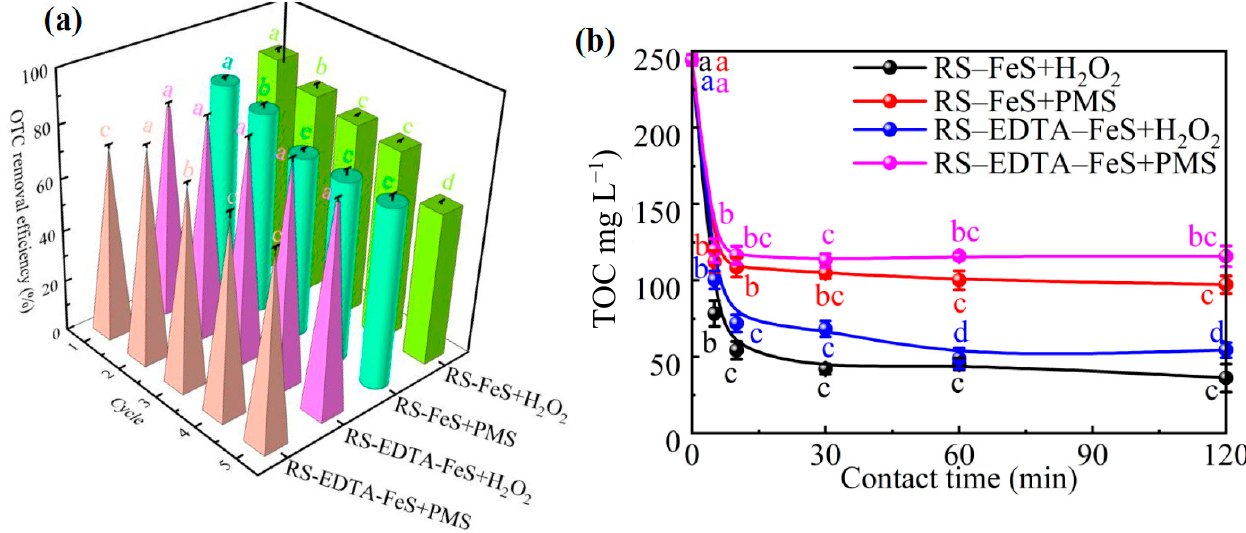
Figure 9. ( a ) Cycling test of RS–FeS and RS–EDTA–FeS for OTC removal in PMS and H 2 O 2 systems (C 0 = 20.00 mg L − 1 , [PMS] = 0.20 g L − 1 , [H 2 O 2 ] = 6.60 mM, initial pH in H 2 O 2 system = 3.00, initial pH in PMS system = 6.00, [t] = 120.00 min). ( b ) TOC removal by RS–FeS and RS–EDTA–FeS in PMS and H 2 O 2 systems from swine wastewater. (Initial TOC concentration = 244.3 mg L − 1 , [PMS] = 0.20 g L − 1 , [H 2 O 2 ] = 6.60 mM, initial pH in H 2 O 2 system = 3.00, initial pH in PMS system = 6.00). Error bars represent the standard deviations ( n =3); di ff erent lowercase le tt ers represent signi fi cant di ff erence between di ff erent treatments ( P < 0.05).